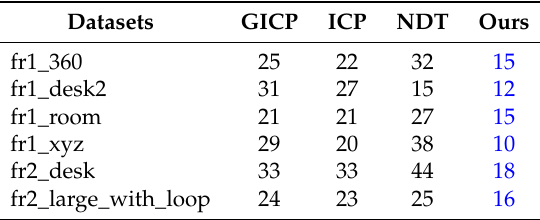
Table 1. Average registration time for each algorithm (ms) (The blue number highlights the best results for each specific dataset among all of the compared